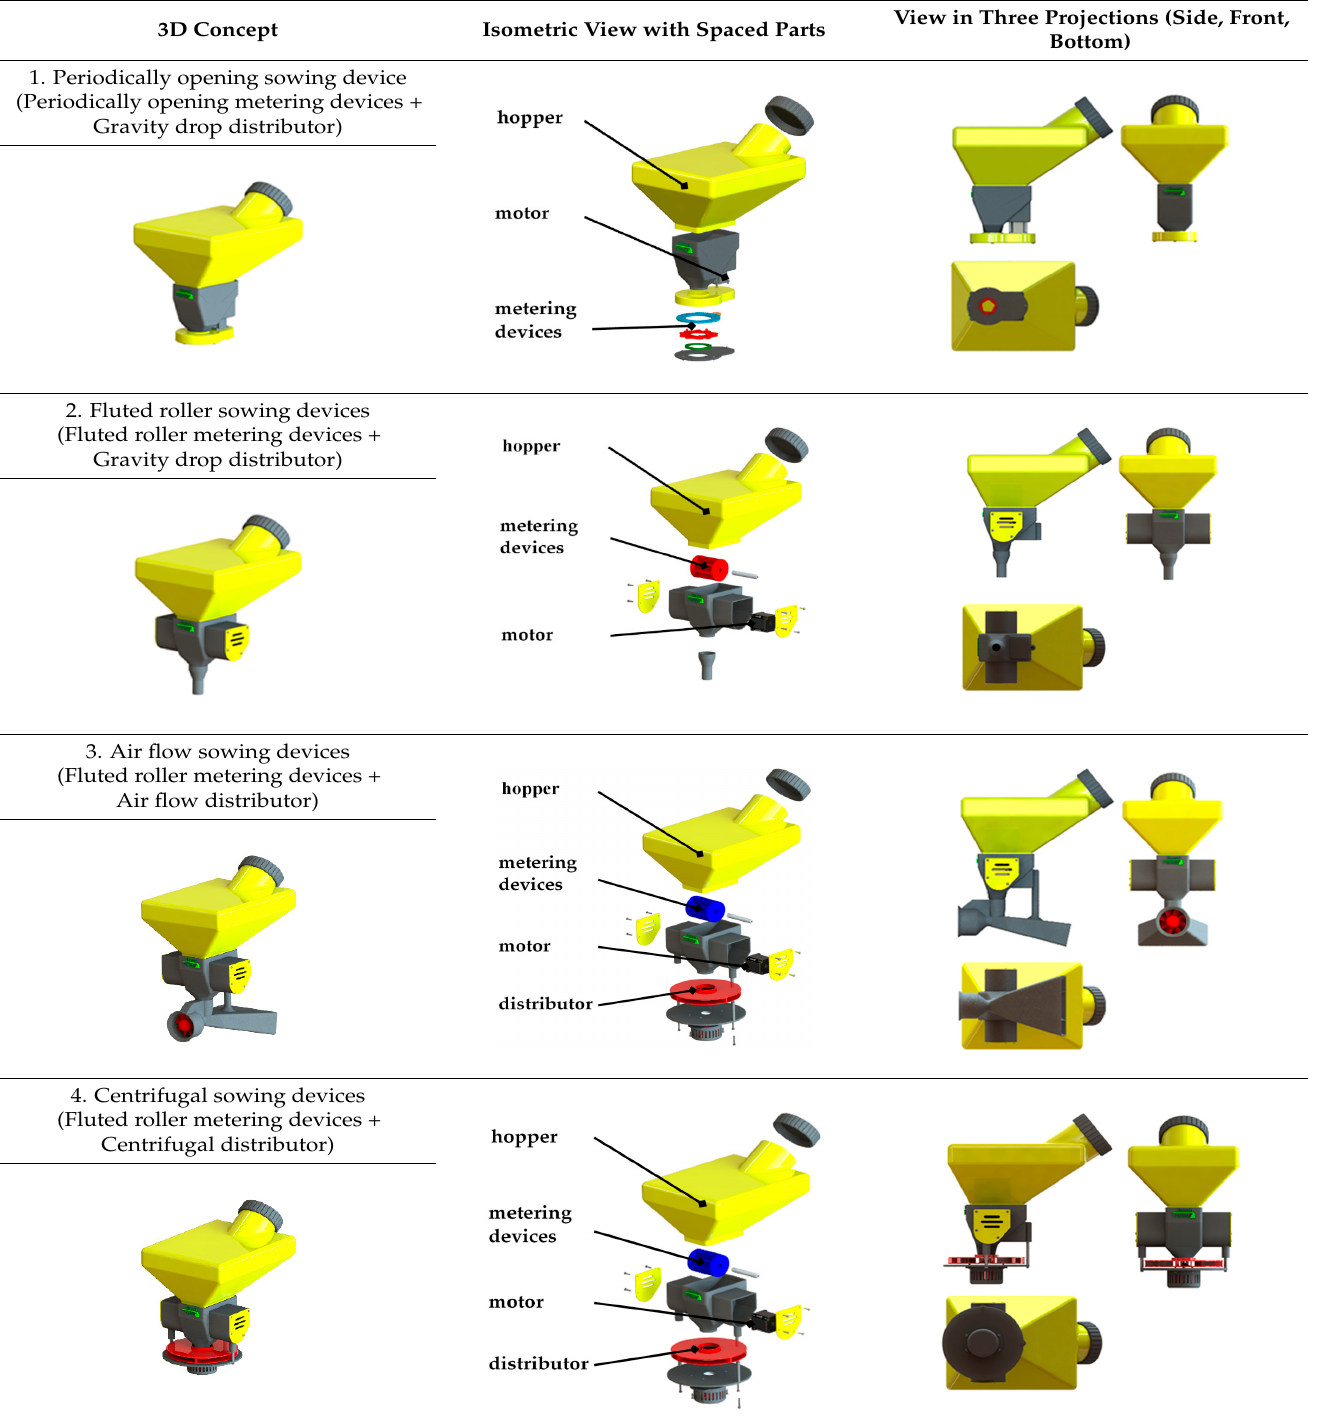
Table 1. Sowing device for flow Table 1. Sowing device for flow sowing. Table 1. Sowing device for flow sowing. Table 1. Sowing device for flow sowing. Table 1. Sowing device for flow sowing. Table 1. Sowing device for flow sowing. Table 1. Sowing device for flow sowing. Table 1. Sowing device for flow sowing. Table 1. Sowing device for flow sowing. Table 1. Sowing device for flow sowing. Table 1. Sowing device for flow sowing. Table 1. Sowing device for flow sowing. Table 1. Sowing device for flow sowing.